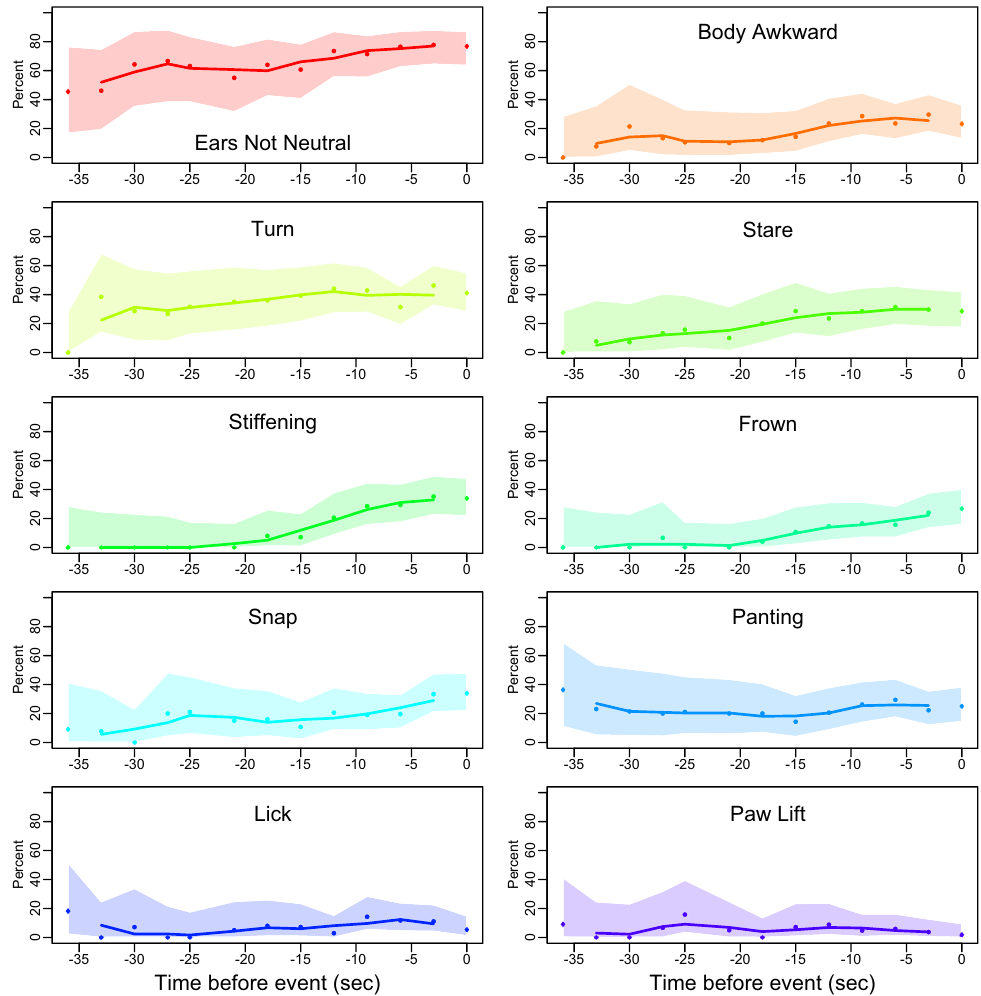
Figure 1. Patterns of changes in dog body carriage (ears and body posture), dog behaviour (head/ body turning, staring, stiffening, frowning, snapping, panting, lip licking, paw lifting) preceding the bite. Dots indicate observed proportions, lines represent 3-point moving averages and the shaded area the 95% confidence intervals for the